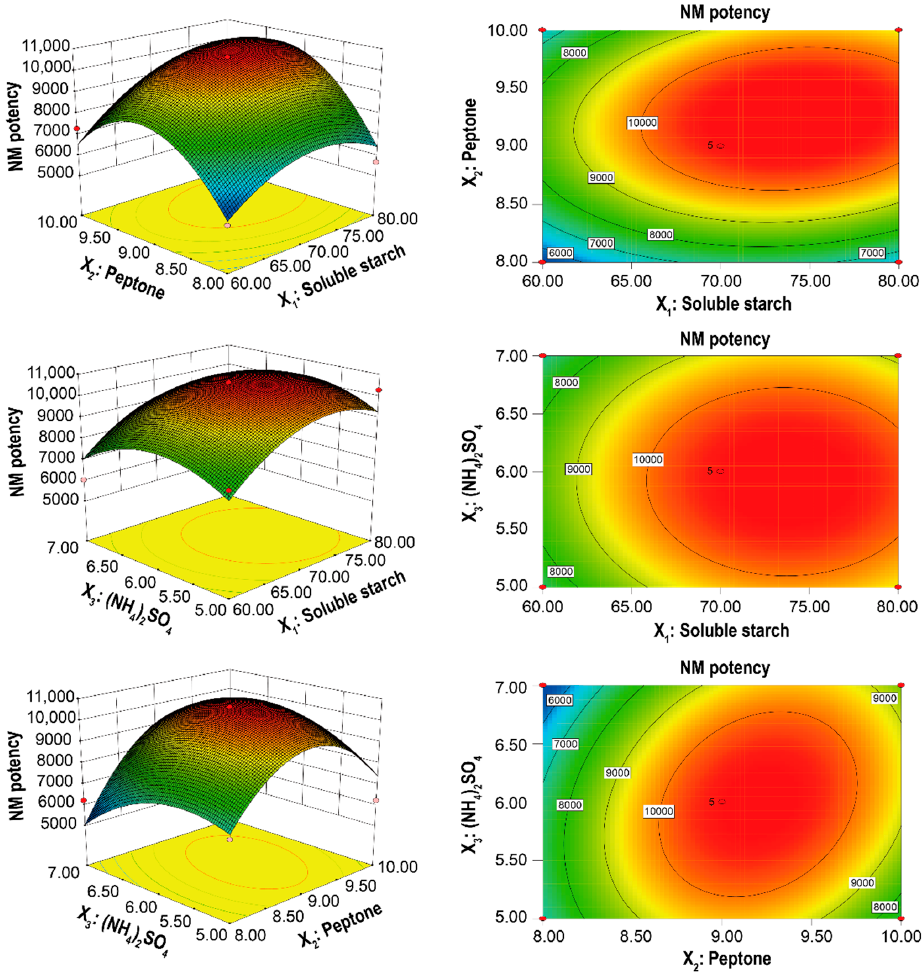
Figure 6. Response surface plots showing the effects of ( X 1 ) soluble starch, ( X 2 ) peptone, and ( X 3 ) (NH 4 ) 2 SO 4 on NM potency.